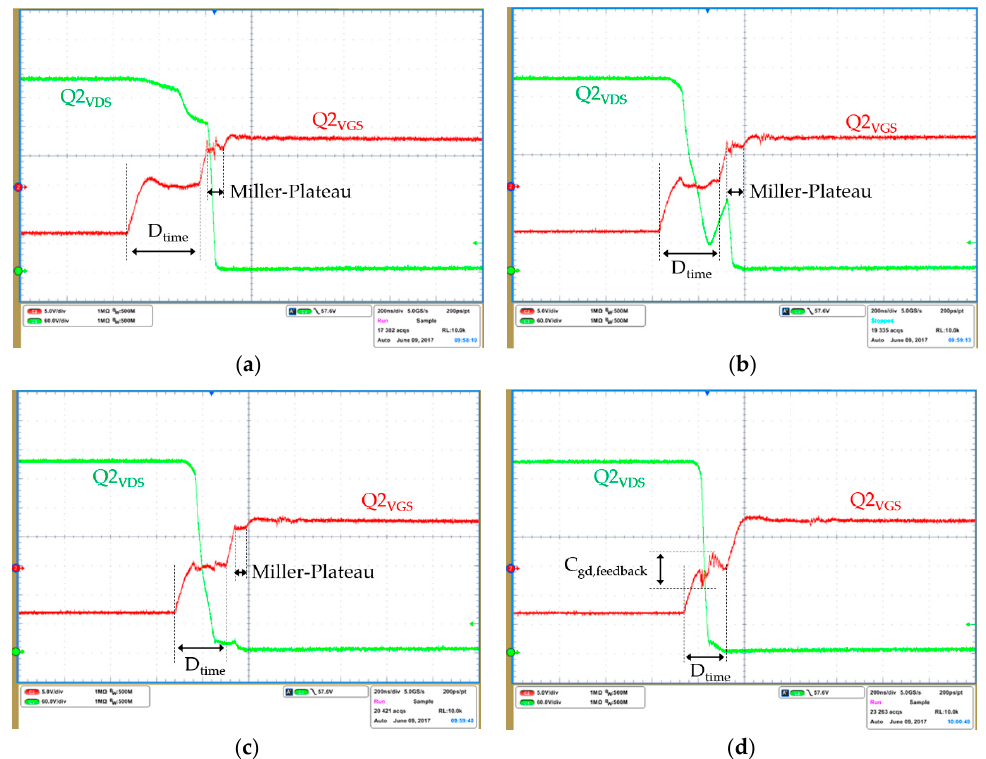
Figure 24. Turn on switching waveforms of the low side switch of the lagging leg at different loads (I o,avg ). ( a ) 25 A of load; ( b ) 60 A of load; ( c ) 75 A of load; ( d ) 117 A of load (100%).